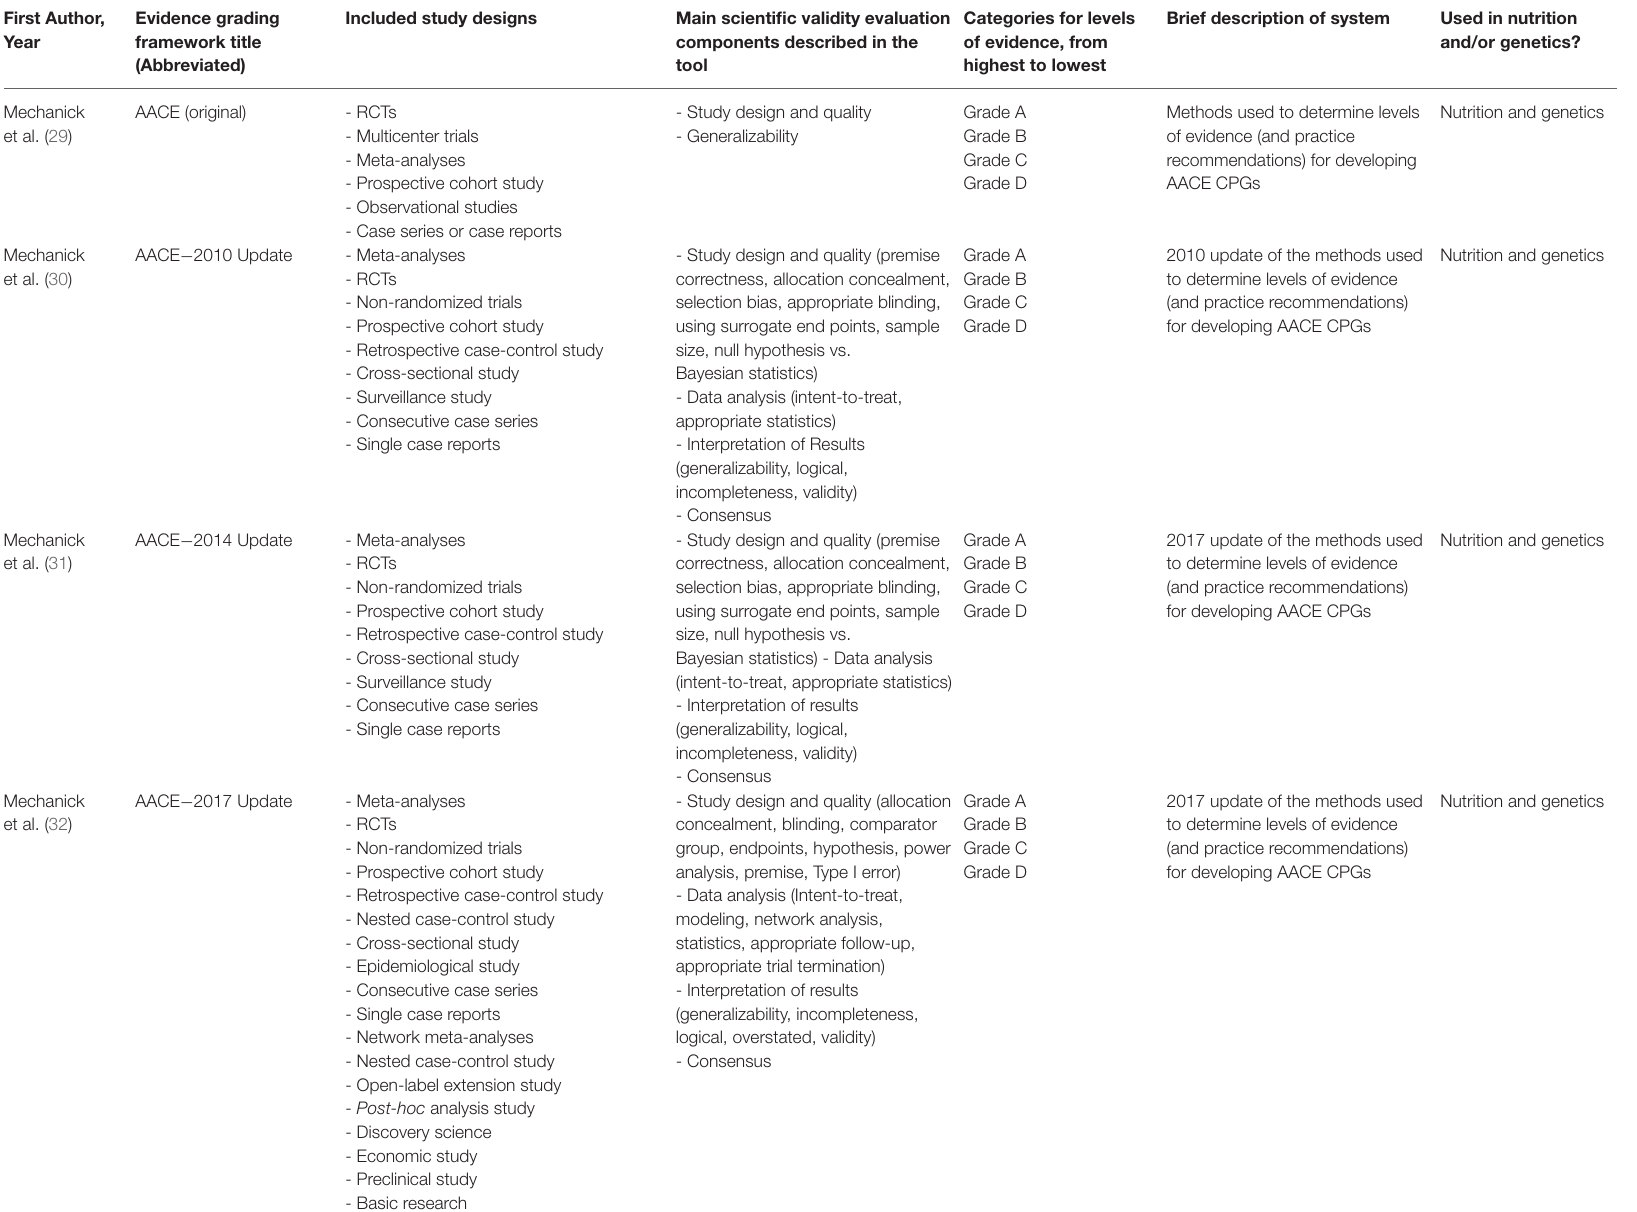
TABLE 2 | Summary of included evidence evaluation frameworks for determining scientific validity in nutrition and/or